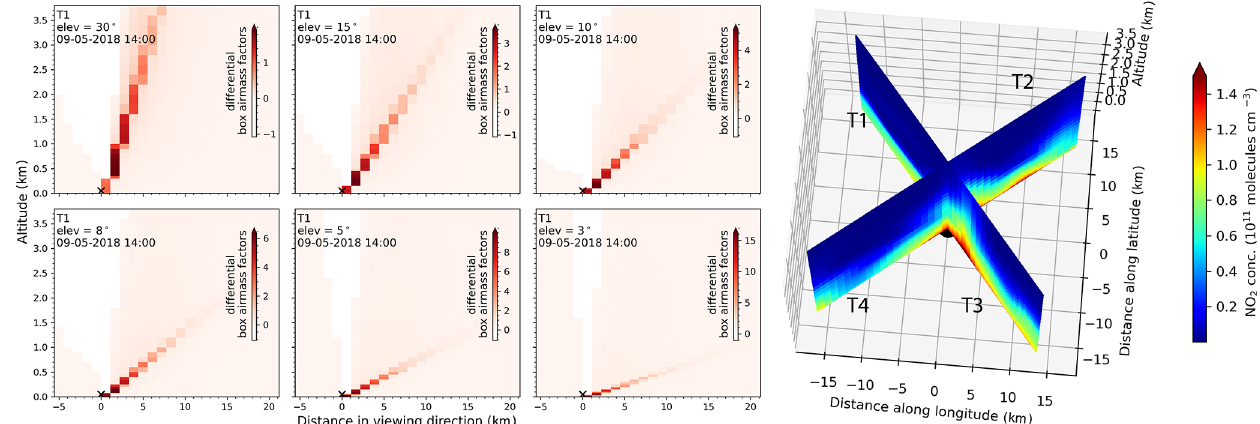
Figure 8. Left: the differential box air mass factors (dbAMFs) for 30, 15, 10, 8, 5 and 3 ◦ elevation angles retrieved using 3D profile inversion of measured O 4 dSCDs along the direction of telescope T1. Please note the different colour scales of differential dbAMFs used for the different elevation angles. Right: simulated NO 2 concentrations from the UBA di set-up in the CM02 domain from surface up to an altitude of 2.5km along the viewing directions of the four telescopes T1, T2, T3 and T4 on 9 May 2018 14:00UTC.